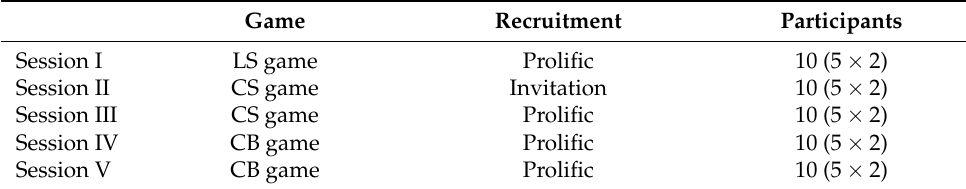
Table 5. Overview of the experimental sessions with 50 participants in total.